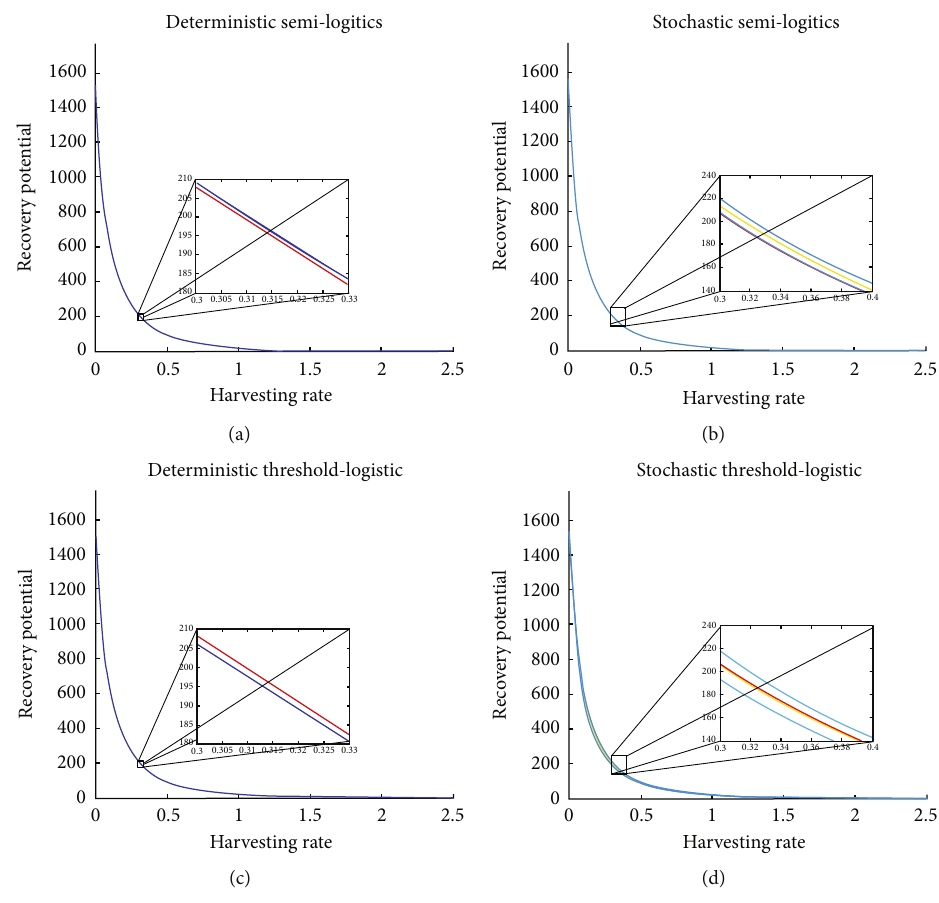
Figure 3: The recovery potential is calculated by using the algorithm described in Appendix B.2. Meng et al. recovery potential (red curve) and nonequilibrium recovery potential (blue curve) w.r.t. harvesting rate for deterministic case (a, c). The mean value of the stochastic nonequilibrium recovery potential (yellow curve) and the interval of standard deviation (68%) of the stochastic nonequilibrium recovery potential (light blue curves) w.r.t. harvesting rate (b,